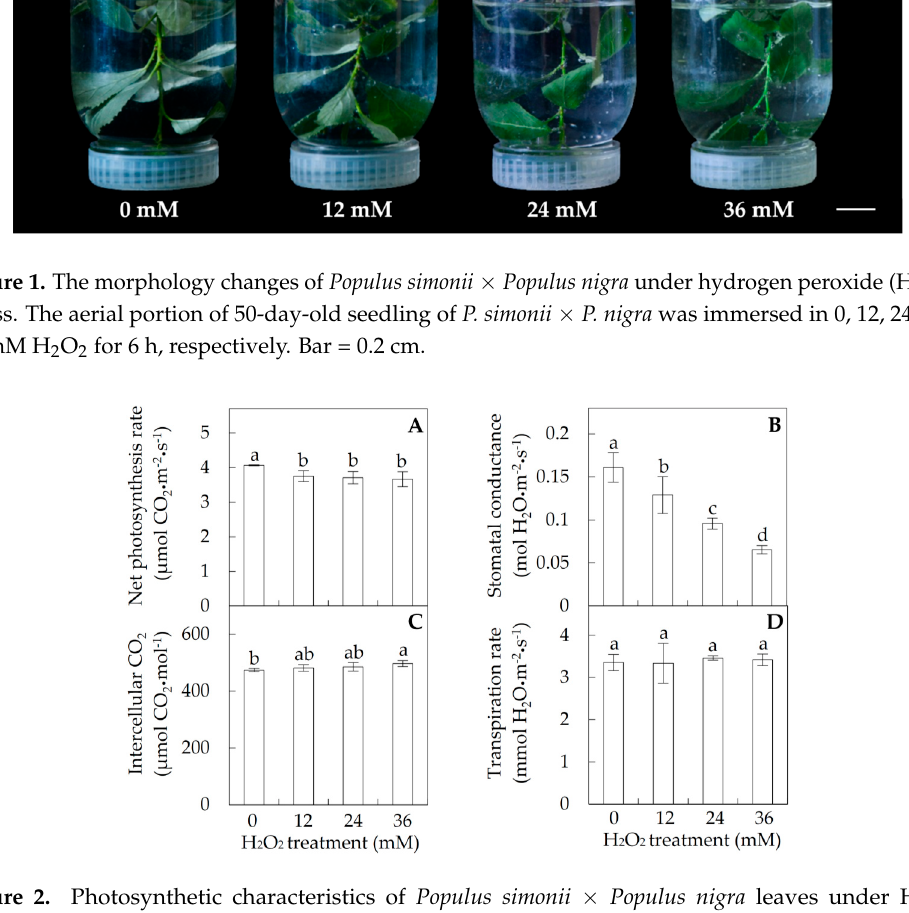
Figure 2. Photosynthetic characteristics of Populus simonii × Populus nigra leaves under H 2 O 2 treatment: ( A ) photosynthesis rate (Pn); ( B ) stomata conductance (Gs); ( C ) intercellular CO 2 (Ci); and ( D ) transpiration rate (Tr). The values were determined after plants were treated with 0, 12, 24 and 36 mM H 2 O 2 , and were presented as means ± standard deviation (SD) ( n = 3). The different small letters indicate significant difference ( p < 0.05) among different treatments.